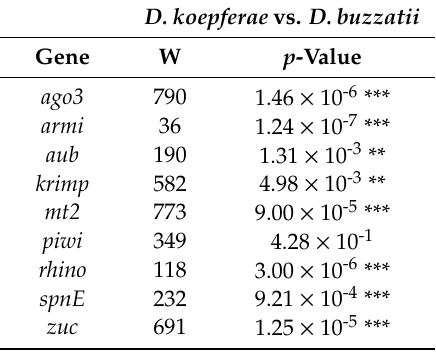
Figure 1. Expression rates in the parental species D. koepferae and D. buzzatii . Note that D. buzzatii females are not involved in the cross. For D. koepferae samples the mean between two families involved in the crosses is shown. Error bars represent standard deviation. Table 3. Comparison between D. koepferae and D. buzzatii expression levels using the Wilcoxon Rank sum test.